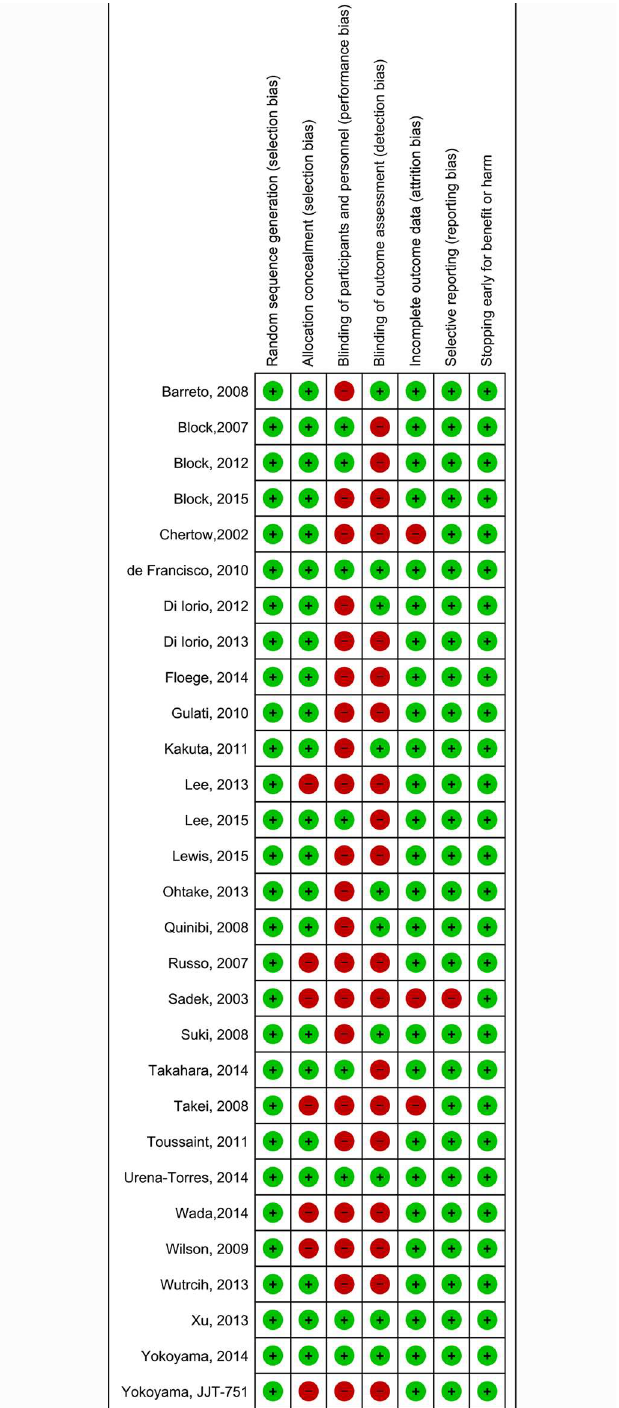
Fig 2. Risk of bias assessment for surrogate outcomes.